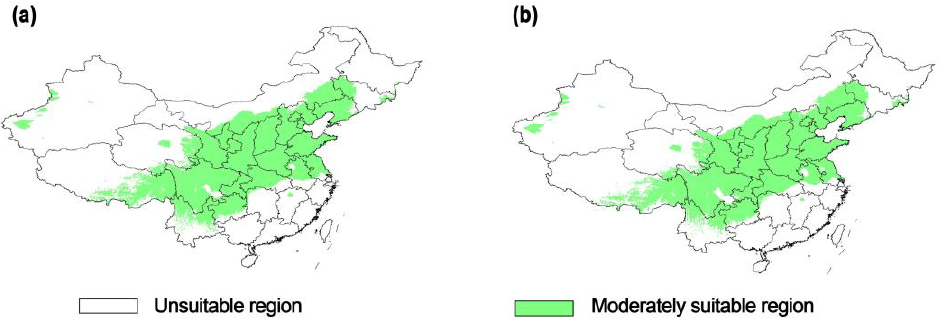
Figure 7. Low impact area under different RCP in the future. ( a ) Low impact area (LIA)-RCP4.5, ( b ) Low impact area (LIA)-RCP8.5.